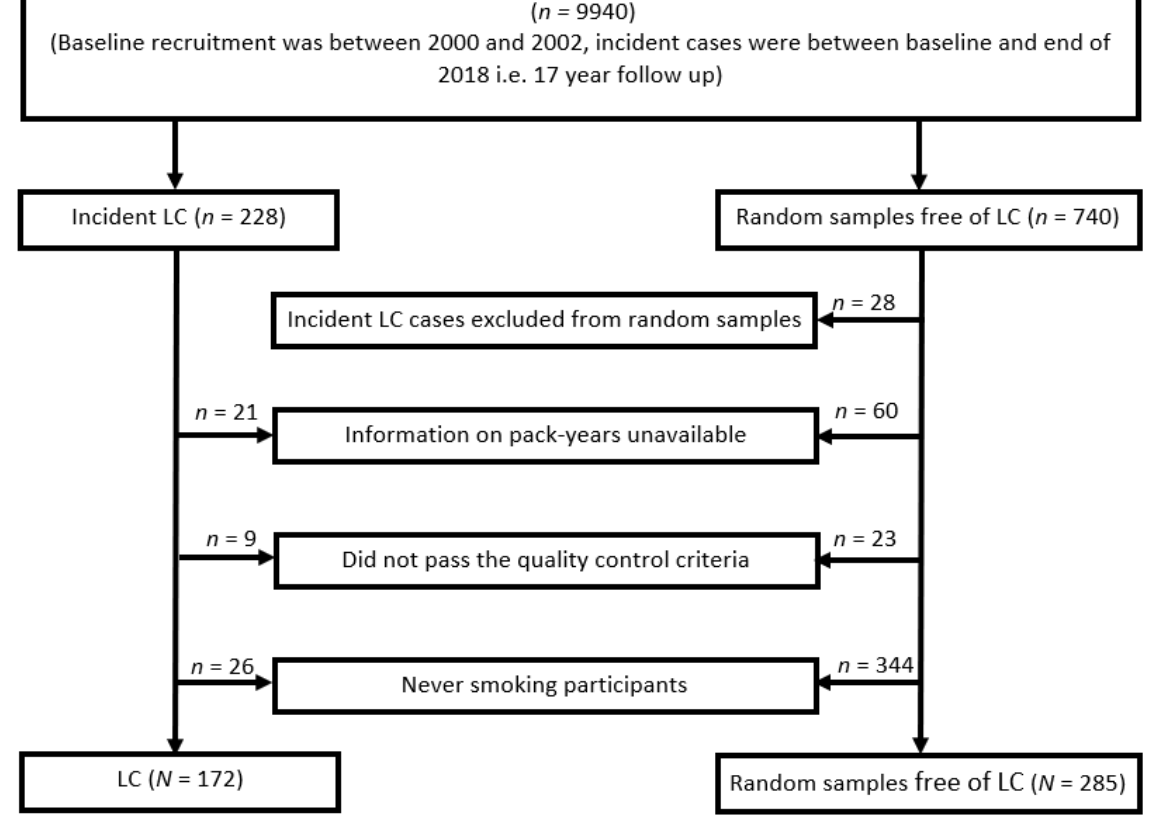
Figure 1. Selection of ever smoking participants from the ESTHER-study. Abbreviations: LC—incident lung cancer; n/N—number.